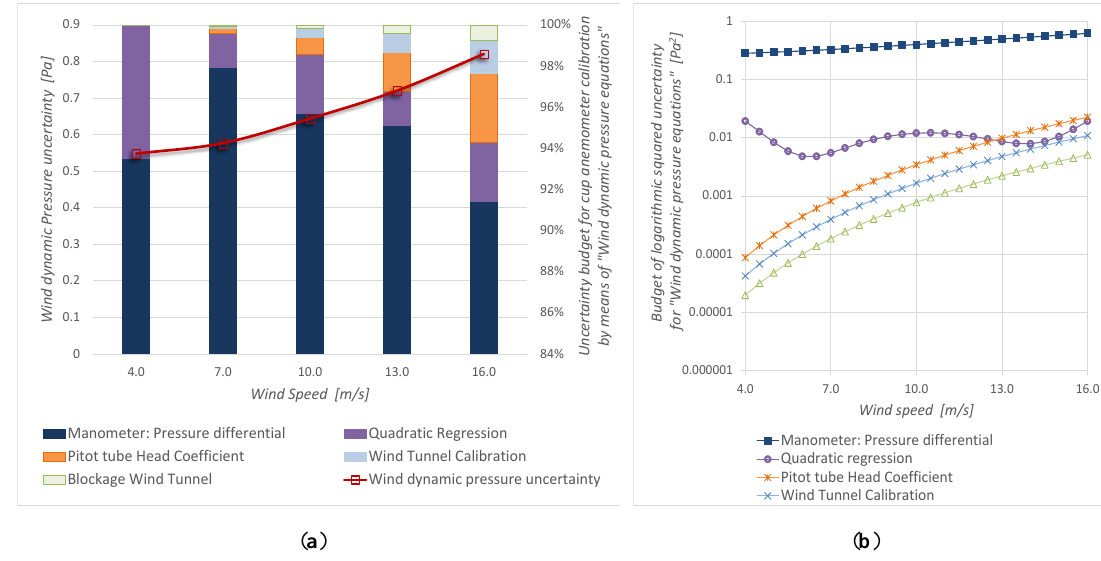
Figure 9. Calibration by means of “Wind dynamic pressure equations” (DYP-Cup anemometer measurement method): ( a ) wind speed uncertainty and its budget, ( b ) components of the squared uncertainty.